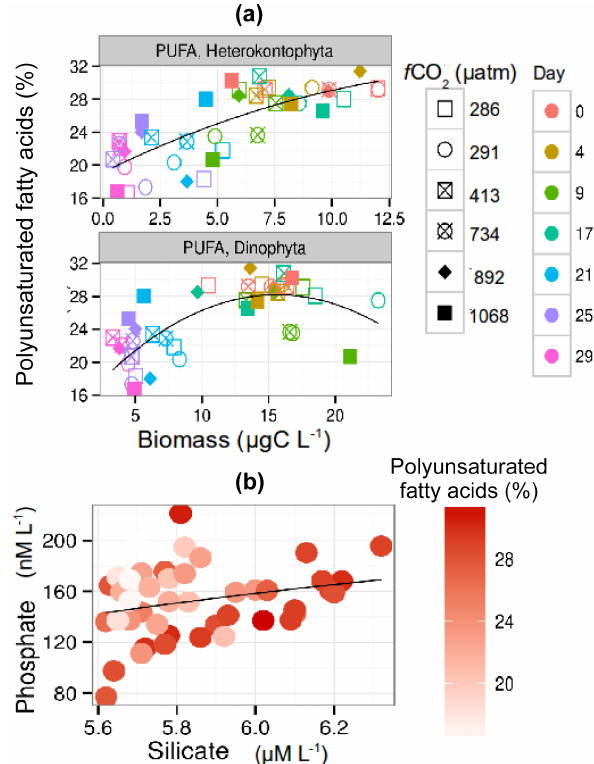
Figure 4. (a) Relation between sestonic relative polyunsaturated fatty acids (PUFAs) with heterokontophyta (PUFA, heterokonto- phyta) and dinophyta (PUFA, dinophyta) biomass. (b) Relation be- tween relative sestonic PUFA content with silicate and phosphate abundance in the